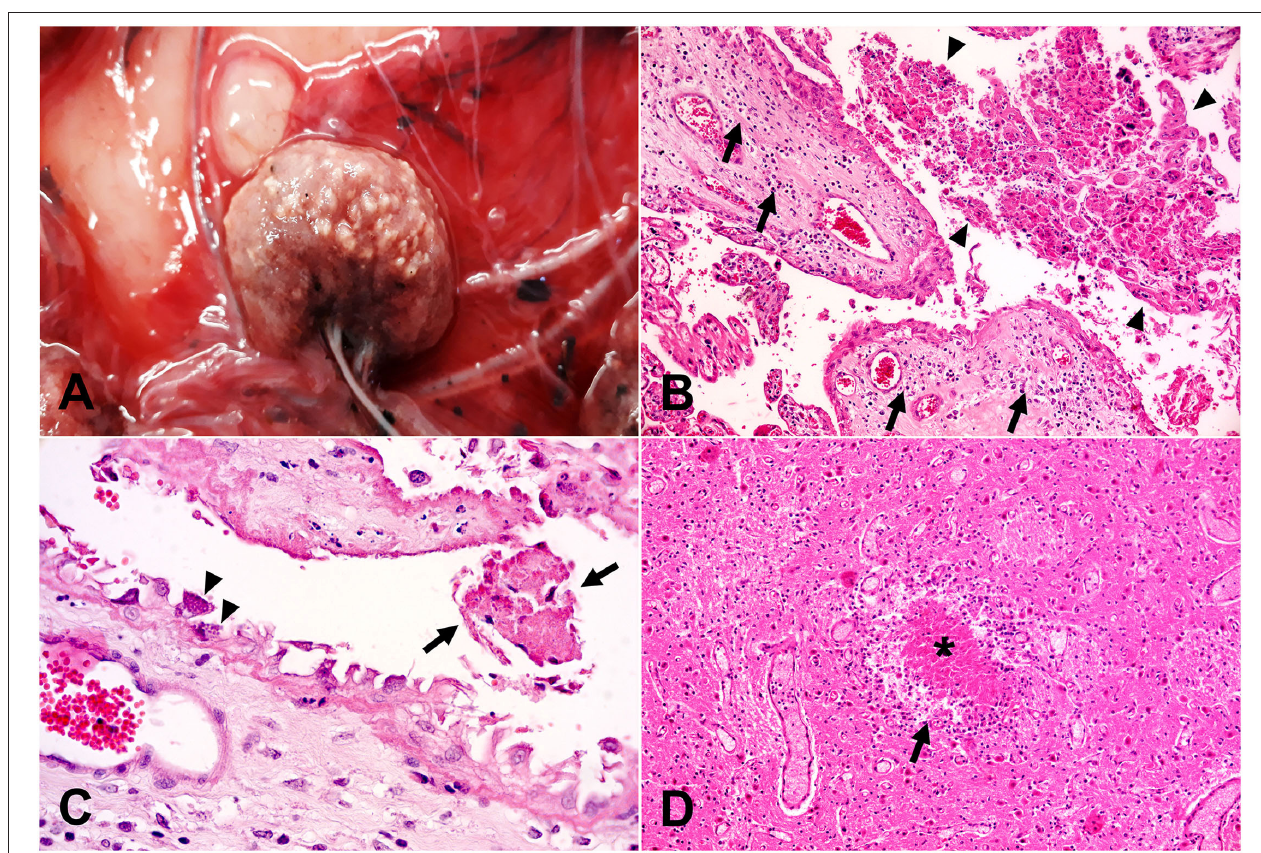
FIGURE 3 | Pathological findings in cases of abortion with etiologic diagnosis of toxoplasmosis. (A) Gross view of a placenta (chorionic membrane) depicting a cotyledon (center) containing multiple, well-demarcated round to oval pale whitish foci of ∼ 1 × 2mm, consistent with foci of necrosis and mineralization (multifocal cotyledonary necrotizing placentitis). (B) Histologic correlate of A, extensive trophoblastic necrosis, and sloughing (arrowheads) along with inflammatory infiltrates (arrows) in the chorionic stroma (necrotizing placentitis). Hematoxylin and eosin stain, original magnification 200 × . (C) Scattered trophoblasts attached to the chorionic stroma contain large numbers of intracytoplasmic pyriform basophilic structures consistent with T. gondii zoites (arrowheads) adjacent to an area with sloughed trophoblastic necrotic debris (arrows). Hematoxylin and eosin stain, original magnification 630 × . (D) Brain, necrotizing encephalitis characterized by a focal area of necrosis (asterisk) surrounded by a rim of glial and inflammatory cells (arrow). Hematoxylin and eosin stain, original magnification 200 ×